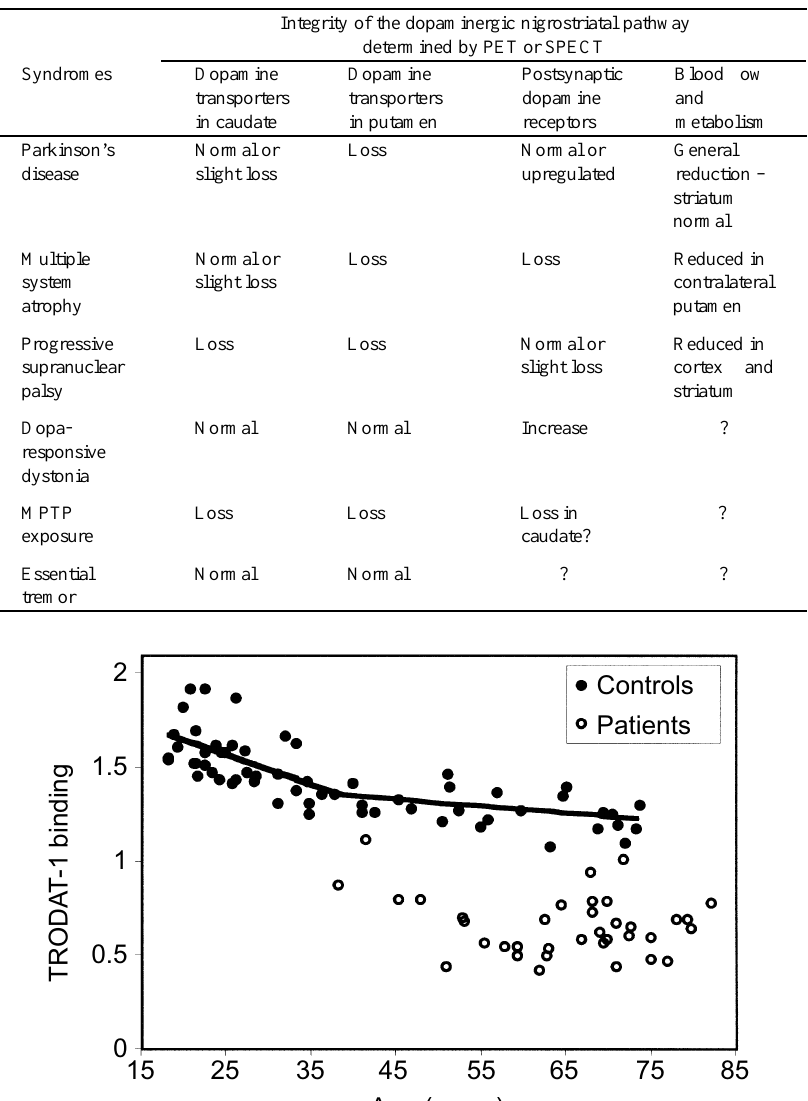
Fig. 1. Age-related decline in the concentrations of dopamine transporters in the striatum, compared with the much greater loss of transporters due to Parkinson’s disease, measured with [ 99m Tc]TRODAT-1 and SPECT [112]. The straight line represents a “broken-stick” model fit to the control data, indicating that the loss of dopamine transporters with normal aging occurs in two distinct phases, with a break-point age around 36